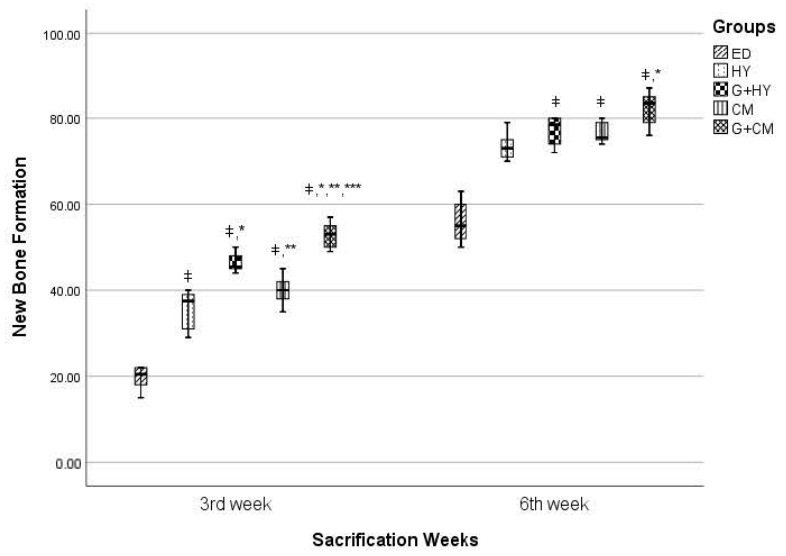
Figure 7. ǂ p < 0.05 when compared with ED. * p < 0.05 when compared with HY. ** p < 0.05 when compared with G+HY. *** p < 0.001 when compared with CM.